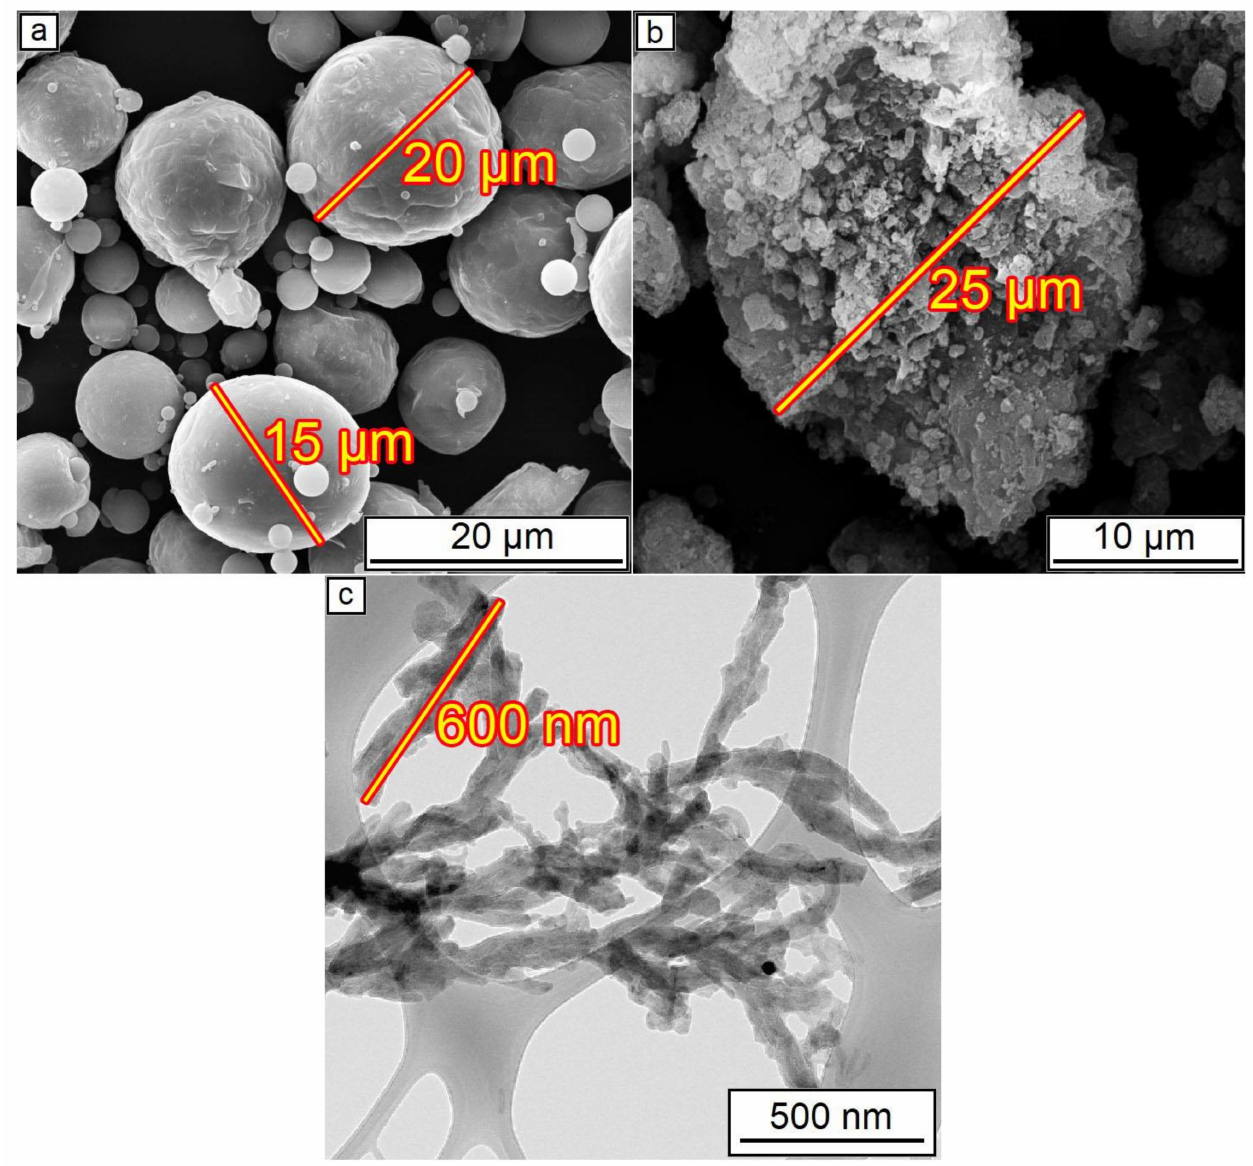
Figure 2. Initial powders before mixing: ( a ) Al powder; ( b ) Al 2 O 3 powder; ( c )